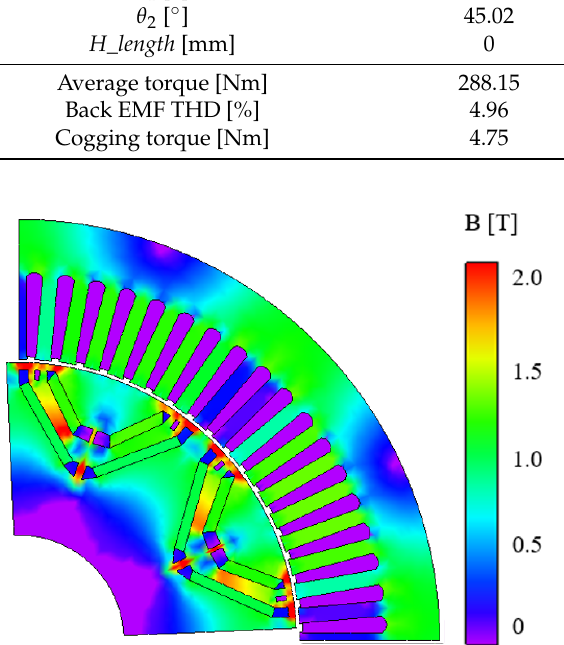
Figure 13. Magnet flux density of the optimal model.